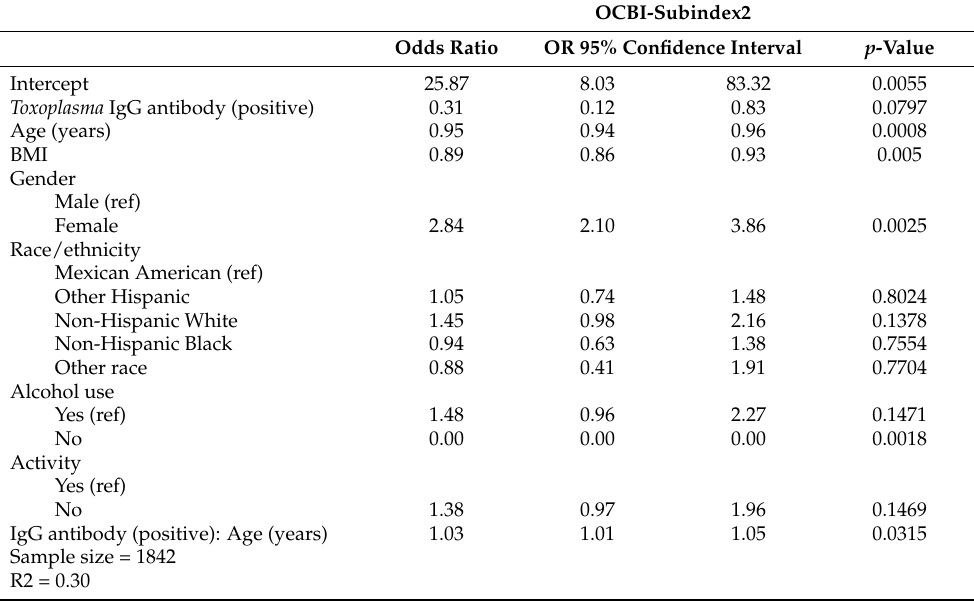
Table 13. Binary logistic regression model for the OCBI-Subindex2 on T. gondii IgG antibody (posi- tive/negative) adjusted for demographic factors and the covariates (after model